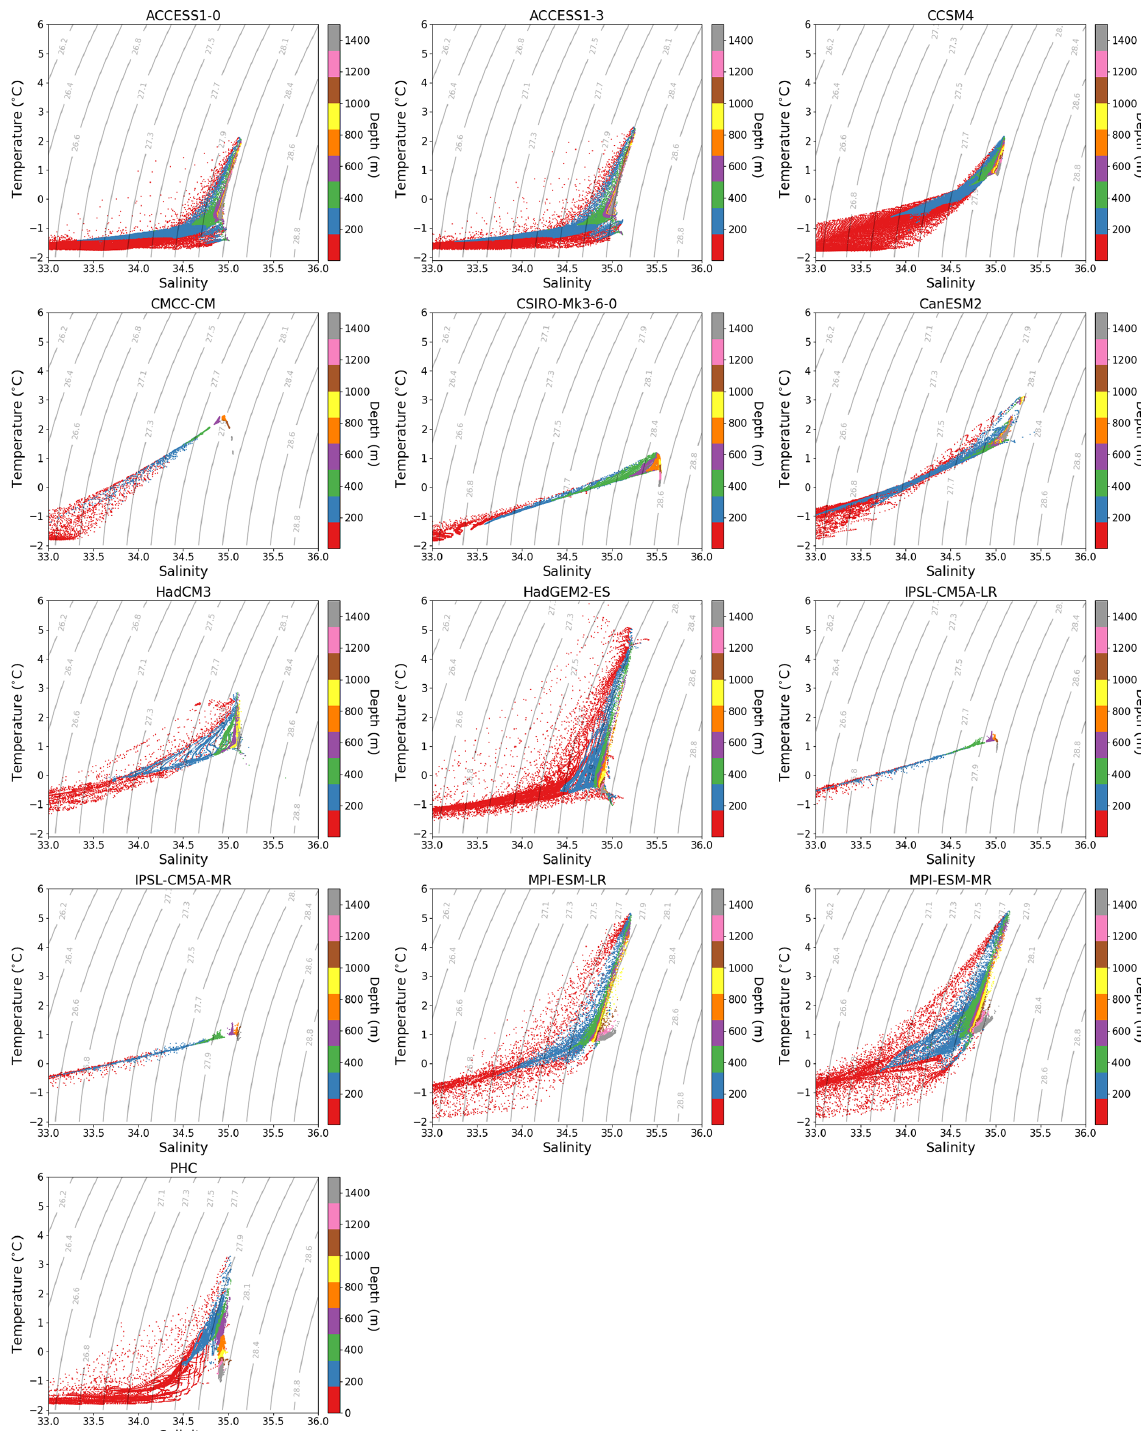
Figure 30. Mean (1970–2005) T – S diagrams for Eurasian Basin of the Arctic Ocean. PHC3.0 shows climatological values for selected CMIP5 models and PHC3.0 observations. Produced with recipe_arctic_ocean.yml ; see details in Sect.